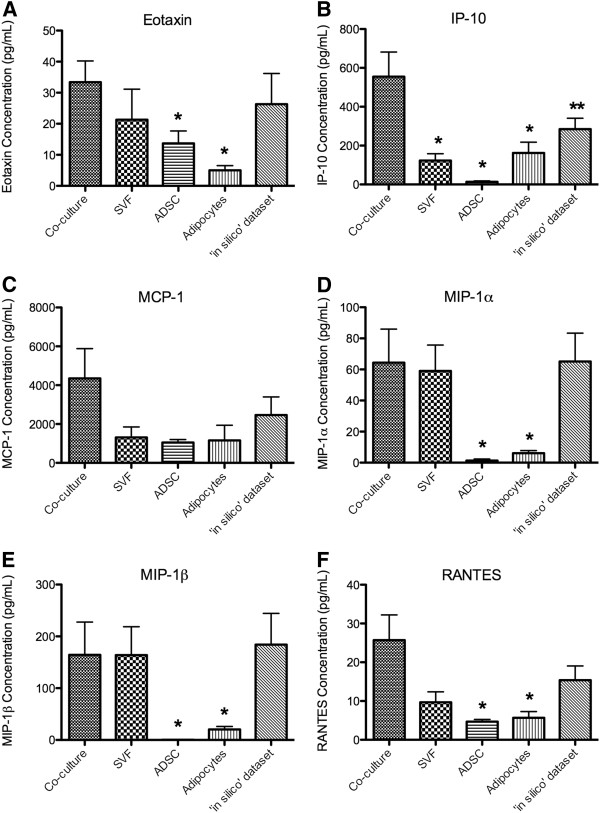
Levels of chemokines measured in conditioned medium of adipose-derived cell populations. The concentrations of the chemokines, eotaxin (A), IP-10 (B), MCP-1 (C), MIP-1α (D), MIP-1β (E) and RANTES (F) were measured in the conditioned medium of the stromal vascular fraction (SVF) co-cultured with adipocytes, SVF, adipose-derived stem cells (ADSC), and adipocytes, as well as the ‘in silico’ dataset. The reported values are the average of 5 biological replicate ± SEM. An * denotes a p-value of ≤ 0.05 and an ** denotes a p-value ≤ 0.1 when compared to the co-culture dataset.